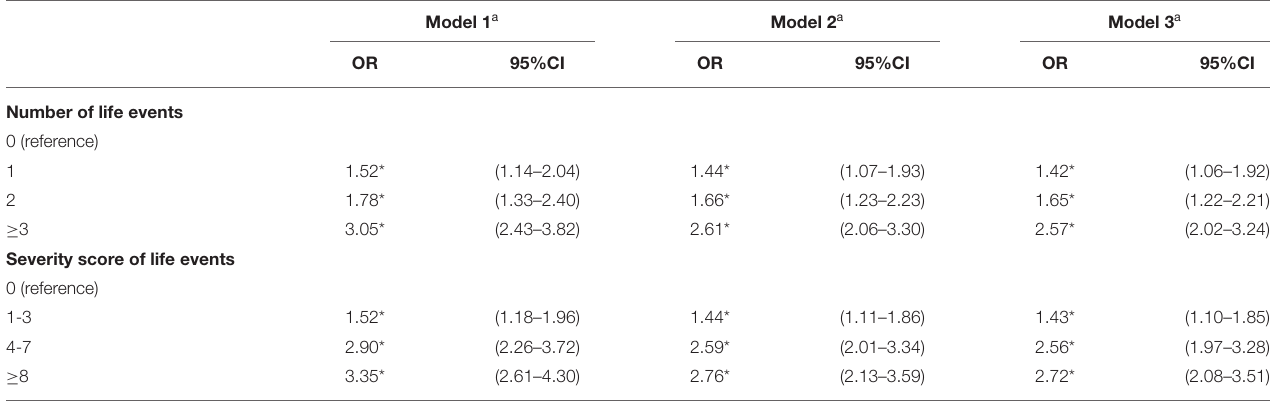
TABLE 3 | Longitudinal associations between cumulative number of life events, cumulative life events severity score and self-reported fatigue.